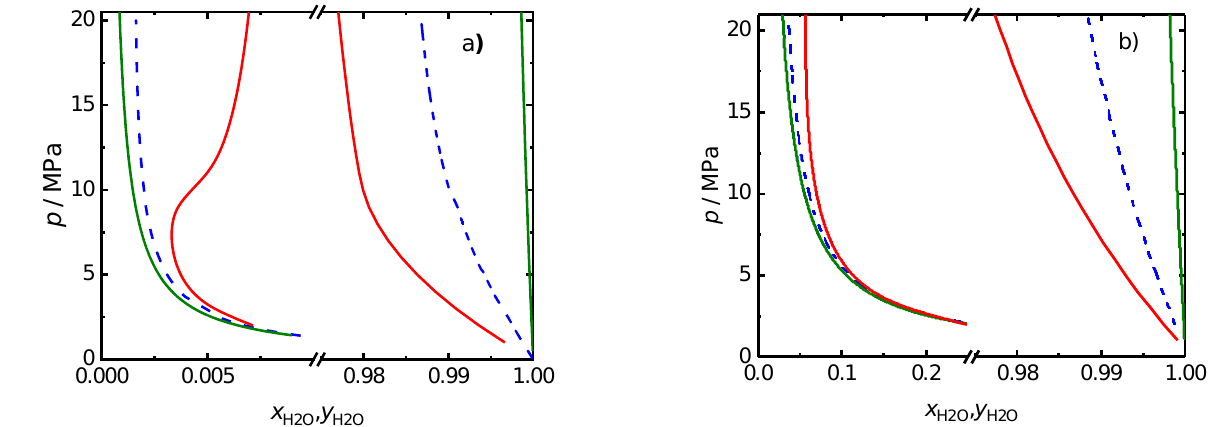
Figure 11. Calculated vapor–liquid equilibrium (VLE) for (N 2 + H 2 O) (green continue line), (CO 2 + N 2 + H 2 O) (blue dash line) and (CO 2 + H 2 O) (red continue line) at 323 K ( a ) and 423 K ( b ). VLE for the CO 2 + H 2 O system calculated with the model proposed by Spycher et al. [20,21]. The VLE for the (CO 2 + N 2 + H 2 O) system and the dew points of (N 2 + H 2 O) was calculated by the SAFT- γ Mie model with parameters from Tables 11 and 13. The bubble points for (N 2 + H 2 O) were calculated with the γ - ϕ model [46].